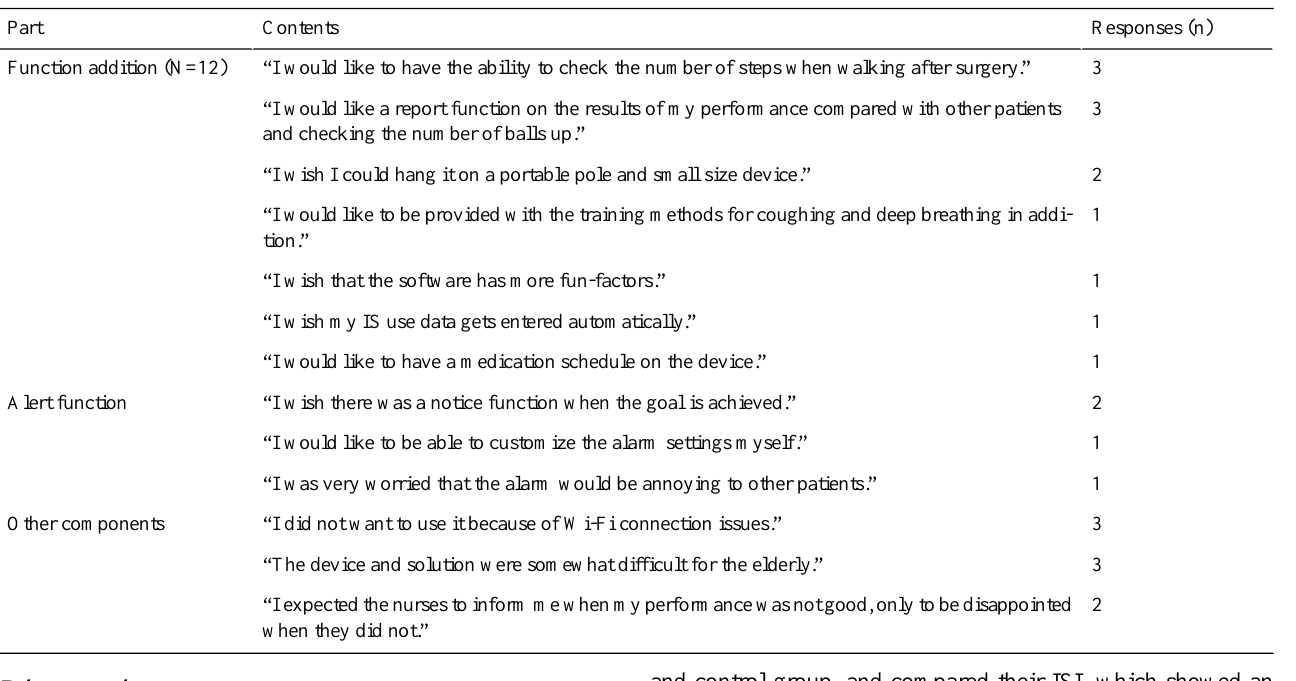
Table 4. Components of the qualitative